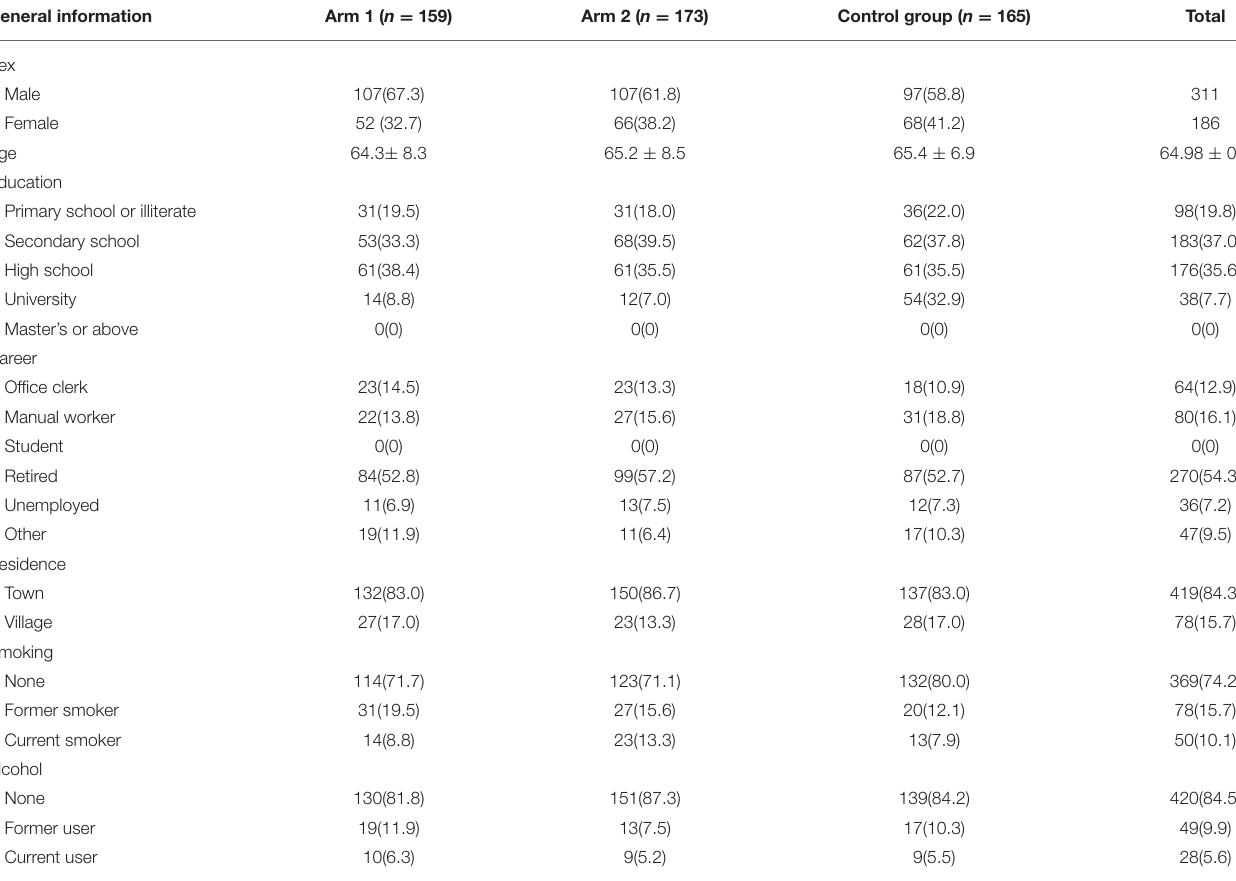
TABLE 1 | Baseline characteristics of patients ( n = 497).